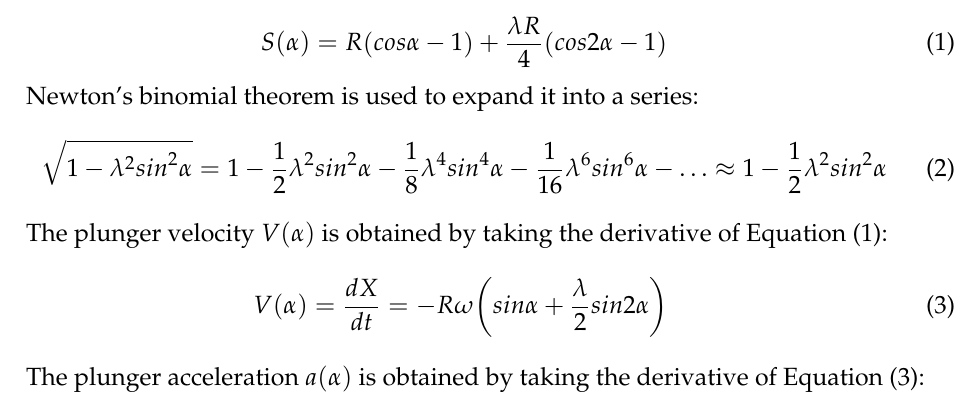
Taking the crank rotation center as the coordinate origin and the crankshaft axis as